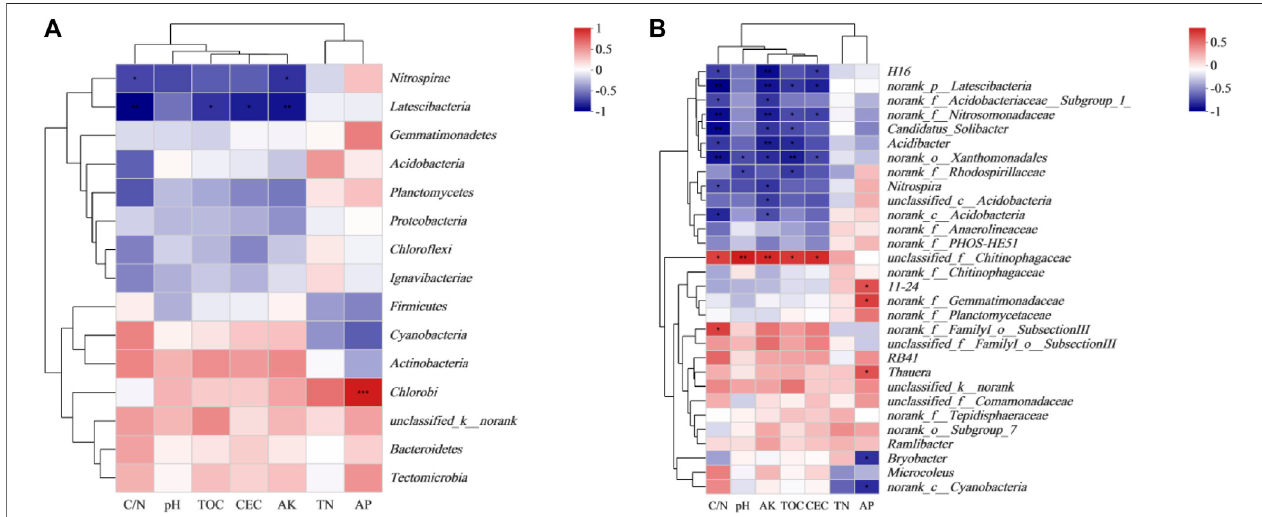
FIGURE 8 | Correlations between dominant bacterial phyla (A) and genera (B) and soil chemical properties. CK: without biochar or rice straw; BC1: 2.25 Mgha − 1 biochar; BC5: 11.25 Mgha − 1 biochar; RS: 2.25 Mgha − 1 rice straw. TN, total nitrogen; AK, available potassium; AP, available phosphorus; CEC, cation exchange capacity; TOC, total organic carbon. ** p < 0.01 and * p < 0.05.